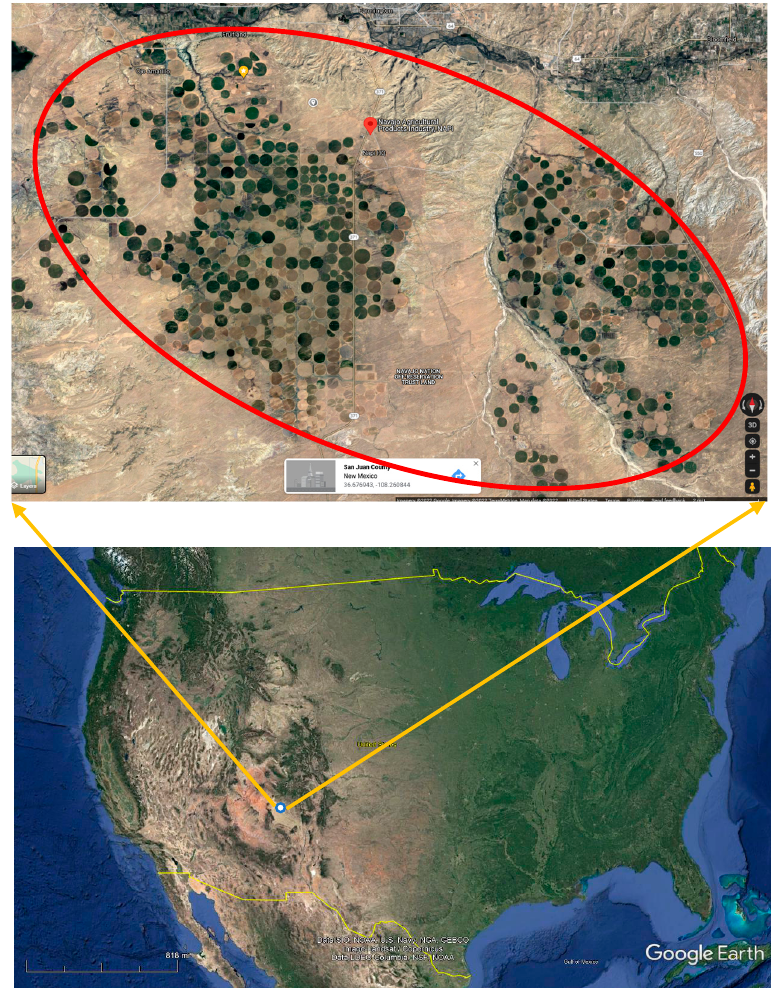
Figure 1. Presentation of the study site in San Juan County, northwestern New Mexico (white dot on the US map) and the Navajo Agricultural Products Industry farm projected as shown by yellow arrows. The green circles are center-pivot-irrigated fields, and the large red circle represents approximately the NAPI farm (downloaded from Google earth on 19 December